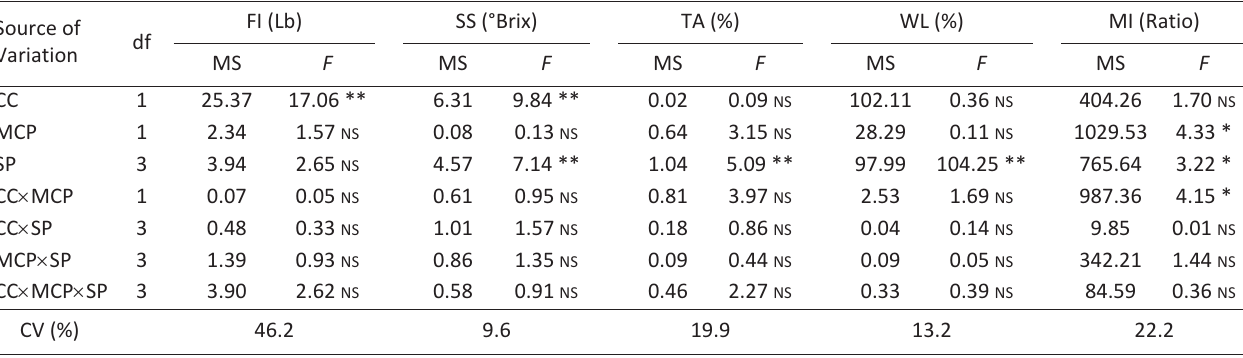
Table 1 ­ Analysis of variance (ANOVA) for parameters evaluated on storage of ripe figs treated with calcium chloride (CaCl methylcyclopropene (1­MCP)